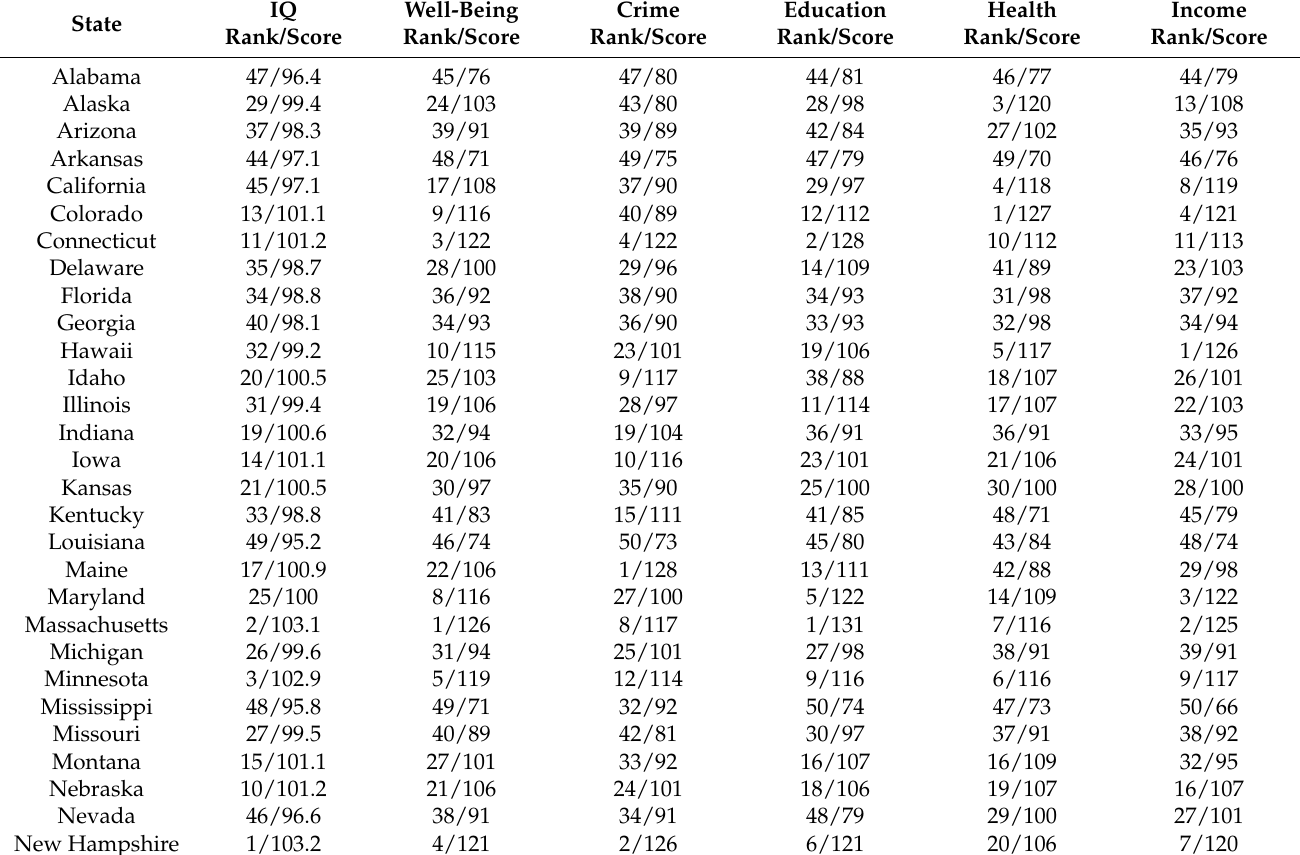
Table 2. State ranks and standard scores for IQ and the well-being